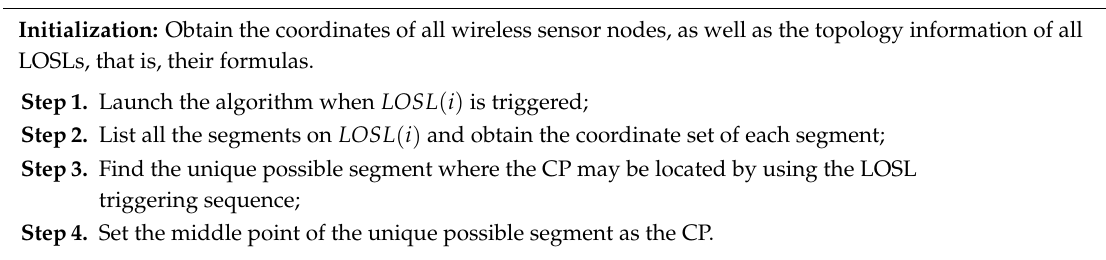
Algorithm 1: CP Estimation on LOSL ( i ) based on the Least-square-error Method. Initialization: Obtain the coordinates of all wireless sensor nodes, as well as the topology information of all LOSLs, that is, their